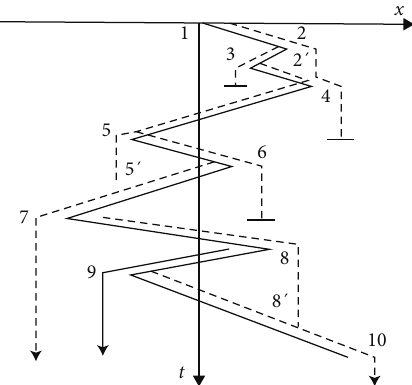
Figure 10: The schematic diagram for the rain-flow counting The time-history curve of the stress in the standard stress level under the train vibration load. So, the standard segment at the bottom is analysed using the rain-flow segment at the bottom of the shield tunnel mainly deter- counting method, and the amplitude, average value, and mines the fatigue life of the structure. The time-history of loading cycles of the stress are finally obtained, which is stress of the standard segment at the bottom is illustrated in illustrated in Figure 12. Figure 11.